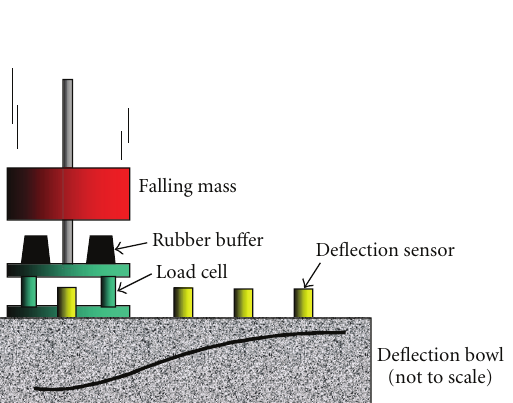
Figure 5: Four-stage construction sequence.